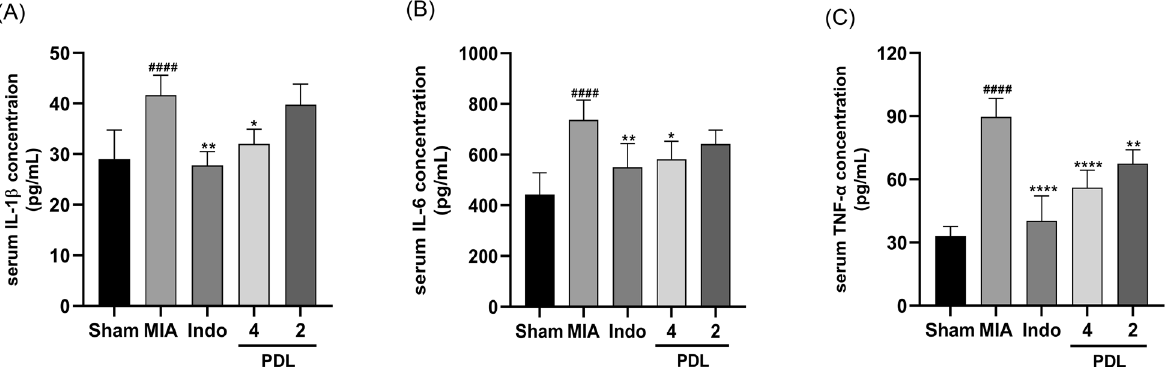
#### p < 0.0001, compared with the Sham group. *p < 0.05, **p < 0.01, ****p < 0.0001, compared with the MIA